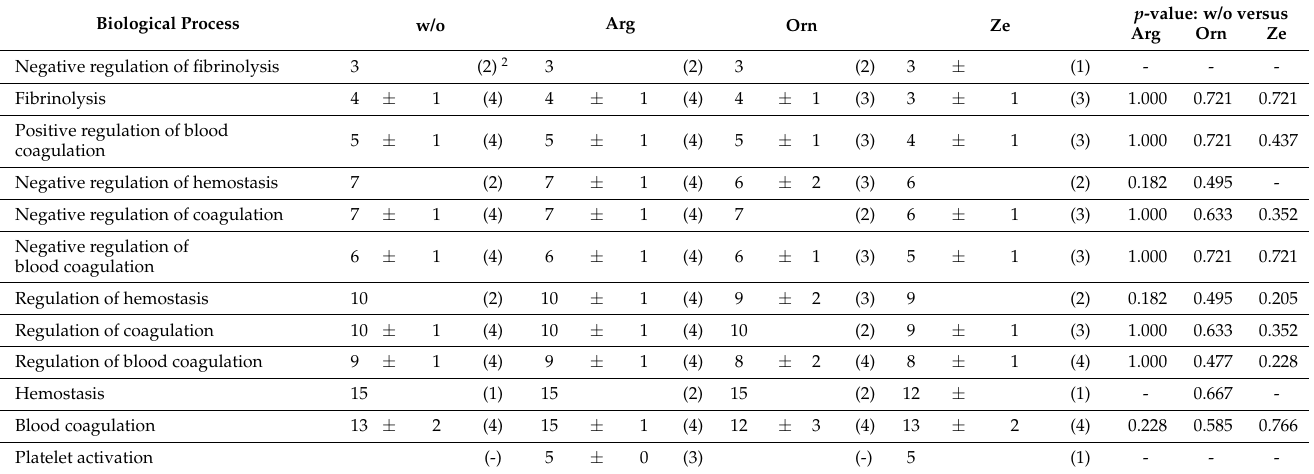
Table 5. Urinary proteins associated with biological processes 1 related to blood coagulation, fibri- nolysis and hemostasis, detected in the urine of cats ( n = 4) fed a high-protein diet without (w/o) or with the supplementation of arginine (Arg), ornithine (Orn) or zeolite (Ze). Mean number of proteins ± standard